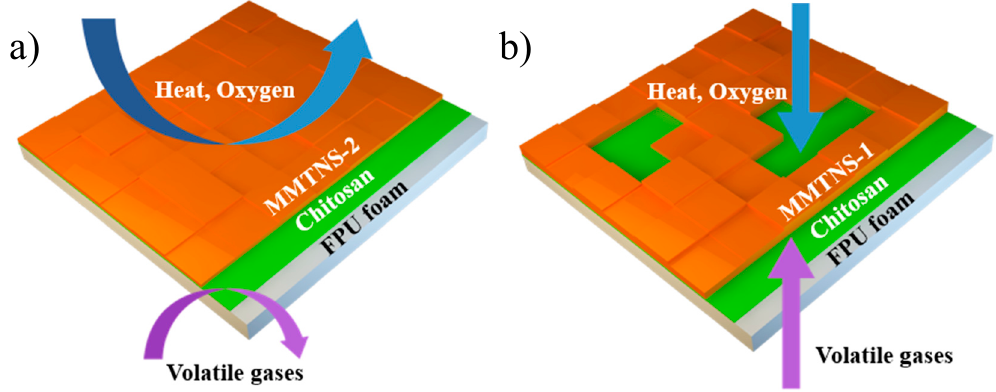
Figure 8. Schematic diagram of the flame-retardant behavior of the CH–MMTNS membranes constructed by MMTNS-2 ( a ) and MMTNS-1 ( b ).